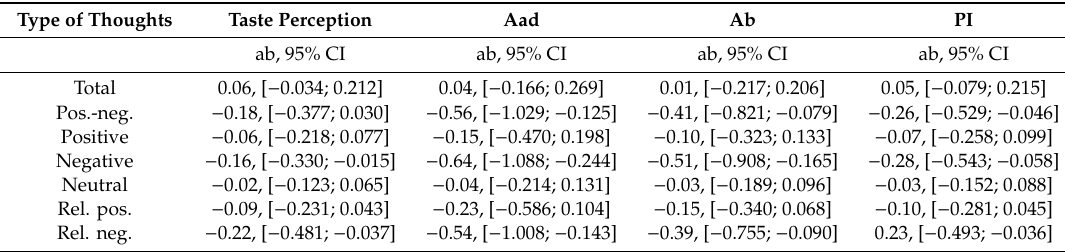
Table 2. Results of Study 2. Overview of mediation analyses for all types of thoughts, with 10.000 bootstraps and 95% bias-corrected intervals (CIs); Dependent variables: Taste Perception, Ad attitude (Aad), Brand attitude (Ab); Purchase Intention